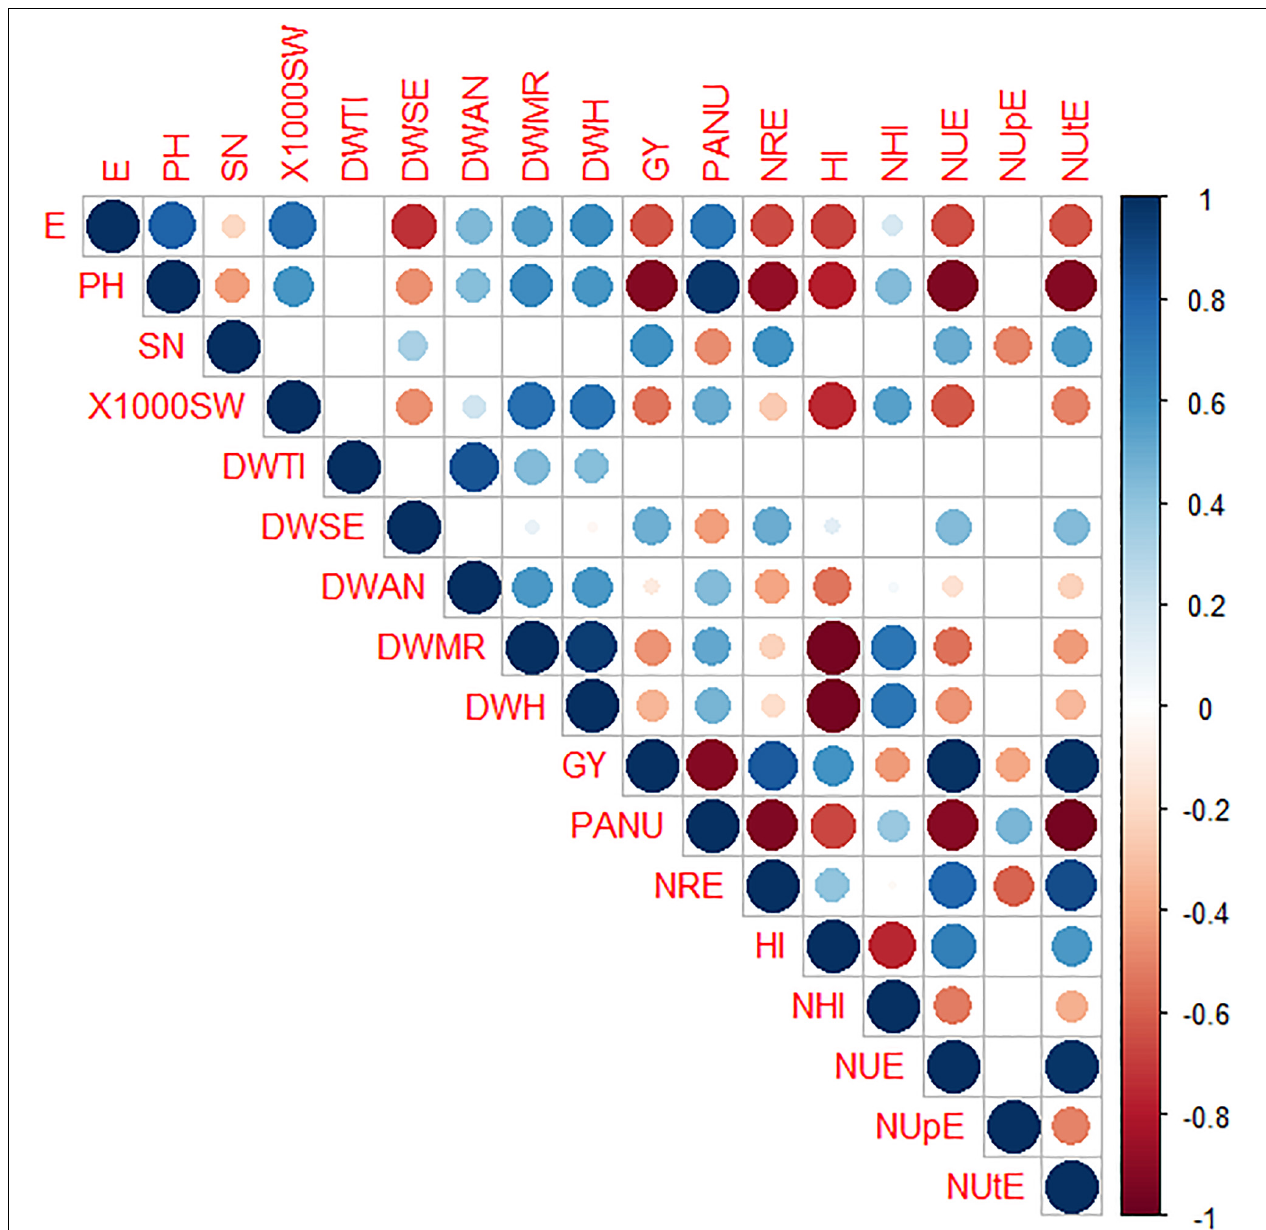
FIGURE 5 | CorPlot of Pearson’s correlation among morpho-physiological traits in eight durum wheat genotypes. Positive and negative correlations are displayed in blue and red, respectively. The color intensity and the circle size are proportional to the correlation coefficients. The absence of circles in the squares indicates values with significance of p > 0.05. DWTI, dry weight tillering; DWSE, dry weight stem extension; DWA, dry weight at anthesis; DWMR, dry weight at milk ripening; DWH, dry weight harvest; E, earliness; PH, plant height; 1000SW, thousand seed weight; SN, spike number; GY, grain yield; HI, harvest index; NHI, nitrogen harvest index; PANU, post-anthesis nitrogen uptake; NRE, nitrogen remobilization efficiency; NUE, nitrogen use efficiency; NUpE, nitrogen uptake efficiency; NUtE, nitrogen utilization